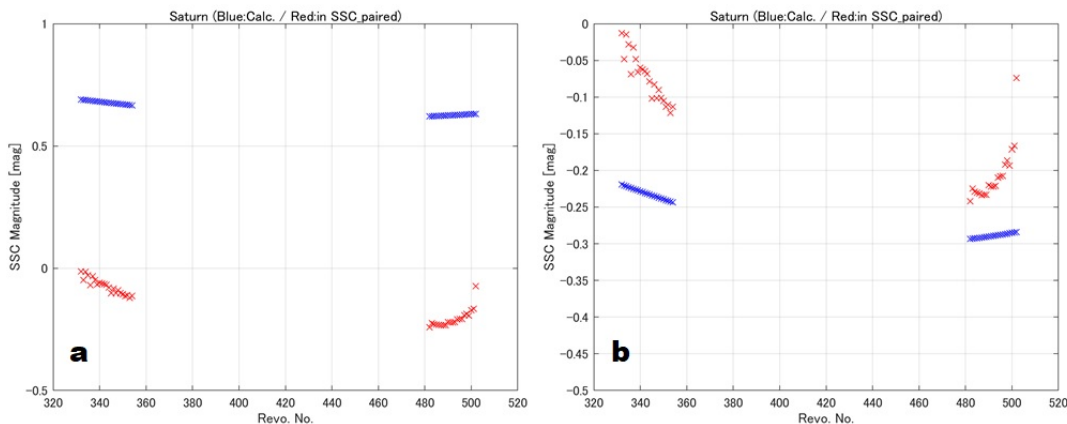
Figure 8. SSC detected (red) and calculated (blue) apparent magnitude for Saturn for specific revolutions that it was detected by the SSC. ( a ) Before the ring effect correction for calculated magnitude; ( b ) after the ring correction,